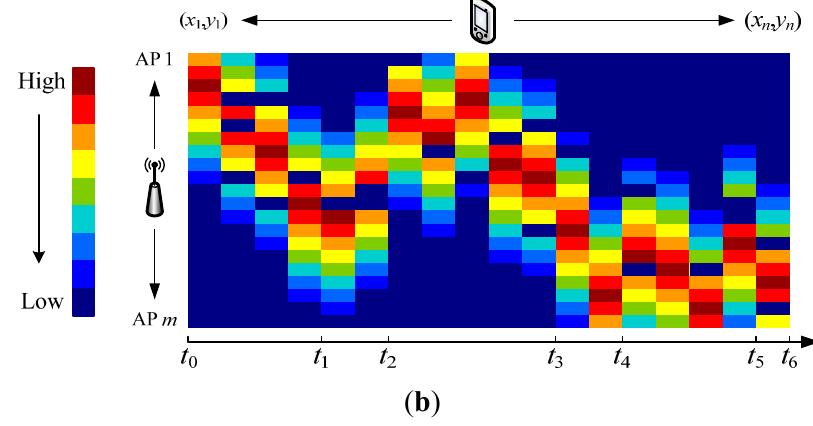
Figure 4. Radio map in green WLAN positioning system. ( a ) Radio map with holes due to no RSS reading sensed; ( b ) Holes are filled arbitrarily with − 100